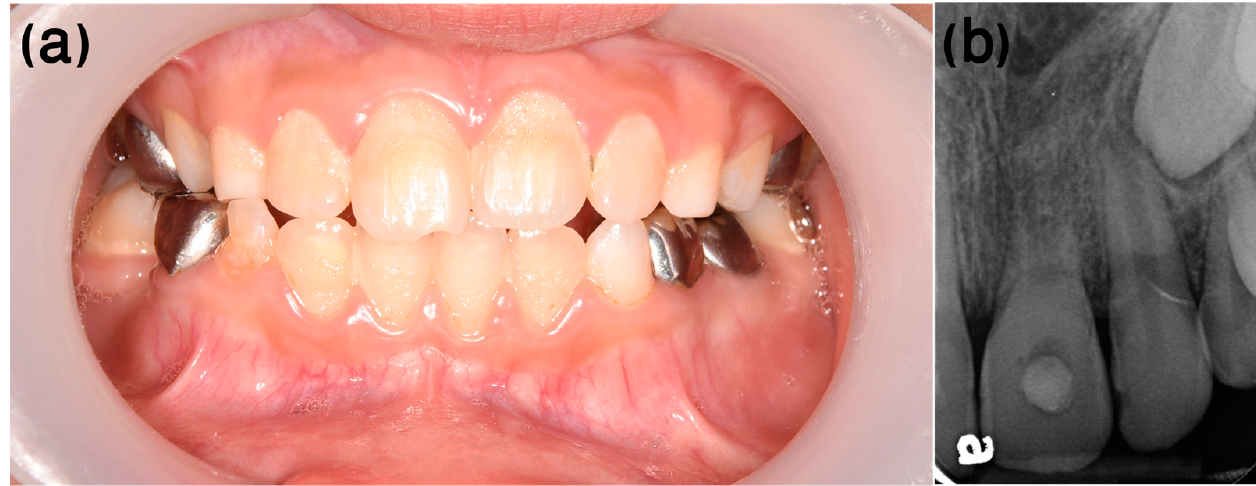
Figure 4. Case 1, four-month follow-up. ( a ) The infra-occluded appearance of the tooth can be noted. ( b ) Root replacement resorption was progressing (the white rotated symbol “a” in the bottom left corner of the figure is part of an embedded symbol in the phosphorus plate by the manufacturer for orientation).